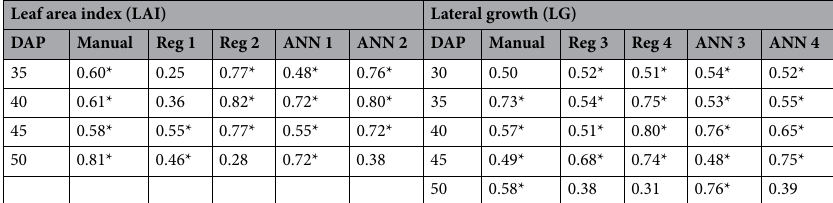
Leaf area index